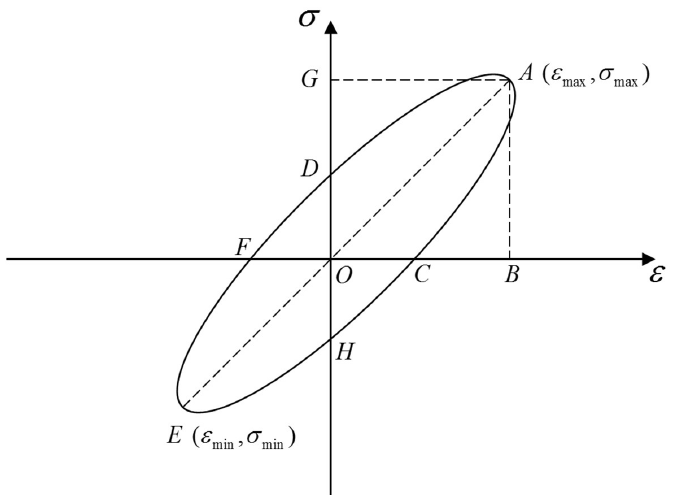
Figure 5. The face of structural EPS concrete before and after micro-cracks appeared: ( a ) 15,500,000 times; ( b ) 16,350,000 times.